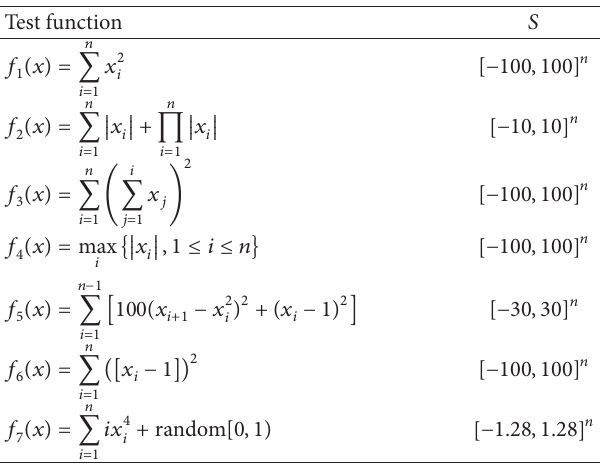
Table 1: Unimodal test